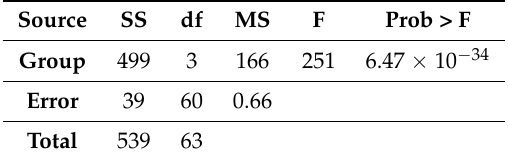
Table 4. Data evaluation in cluster using the ANOVA